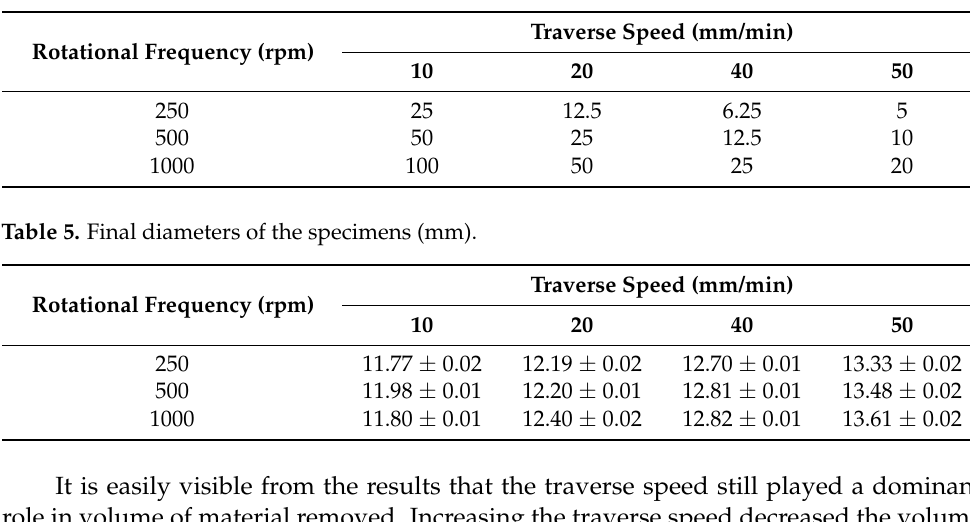
Table 4. Number of passes N for each setup.